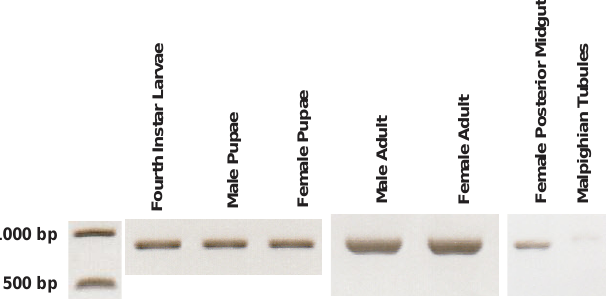
Figure 6. PCR of AeCA9 in each life stage, female posterior midgut, and female Malpighian tubules. The transcript for AeCA9 is 831 bp, and the 1 KB DNA ladder (left) indicates the size of the PCR product. The PCR for each life stage and the posterior midgut was run for 30 cycles and is non-quantitative, while the PCR for the Malpighian tubules were run for 36 cycles and was also not quantitative. AeCA9 was detected in all the life stages analyzed, and AeCA9 transcript was expressed in the PMG and is barely detectable in the MTs.